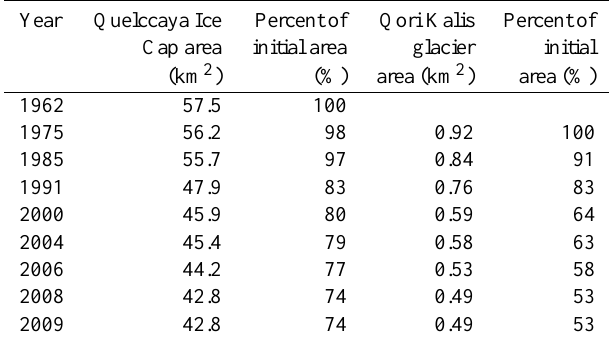
Table 2. Loss of glacier area between 1962 and 2009 for QIC and Qori Kalis, an outlet glacier of the ice